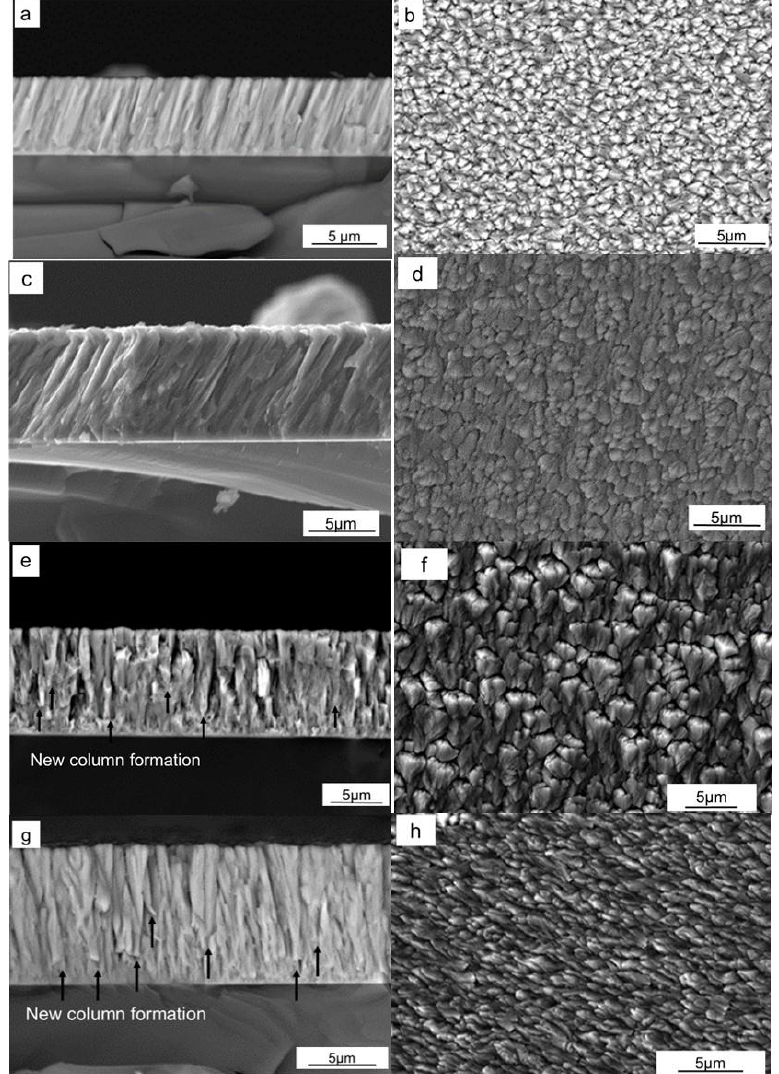
Figure 3e. Strong renucleation of columns could be noticed during deposition at 4.5 kW (Figure 3e,f). Metals 2016 , 6 , 265 This renucleation of columns can be regarded as density defect, which interrupts local epitaxy of the individual columns and takes place when the ion energy becomes large enough to support continuous coating growth [49]. A shark skin structure can be seen for the coating deposited at 4.5 kW in Figure 3h.